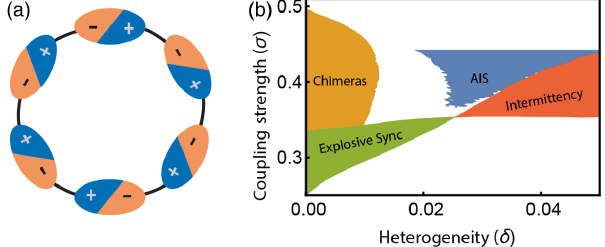
FIG. 1. (a) Model network of phase-phase oscillators, in which phase oscillators with alternating frequencies are sine-coupled to their nearest neighbors on a ring. Regarding each pair of plus- minus oscillators as a Janus oscillator results in a symmetric system of oscillators. In such a ring (shown here with N ¼ 6 oscillators), any two Janus oscillators can be swapped by rotations without changing the overall configuration. (b) The various phenomena exhibited by a ring of N ¼ 50 Janus oscillators as the coupling strength as well as the heterogeneity across the Janus oscillators are varied. Quantitative details about these regimes are presented in Sec.